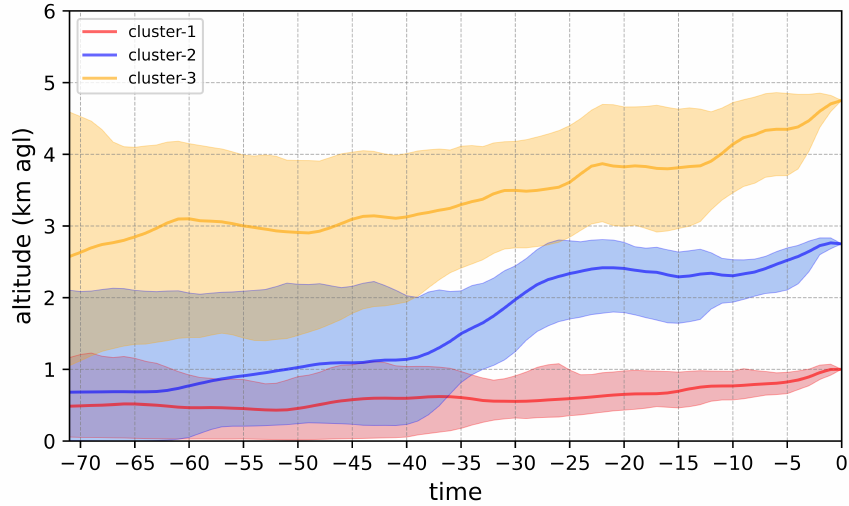
Figure 6. The evolution of moisture transport as a function of altitude and time prior to the extreme rainfall event (18Z, 27 August 2021) for each cluster. The solid line represents the mean altitude for each cluster, while the shading denotes the uncertainty of the moisture